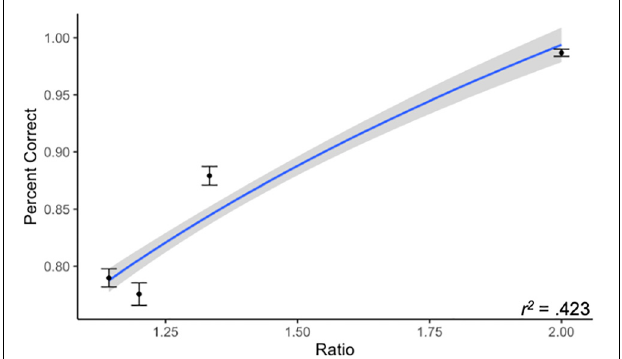
FIGURE 1 | Accuracy by trial ratio. We found that subjects in Experiment 1 conformed to Weber’s law, where accuracy increases as a function of ratio. Line represents best-fitting logarithmic relationship between ratio and percent correct. Gray region represents 95% CI.